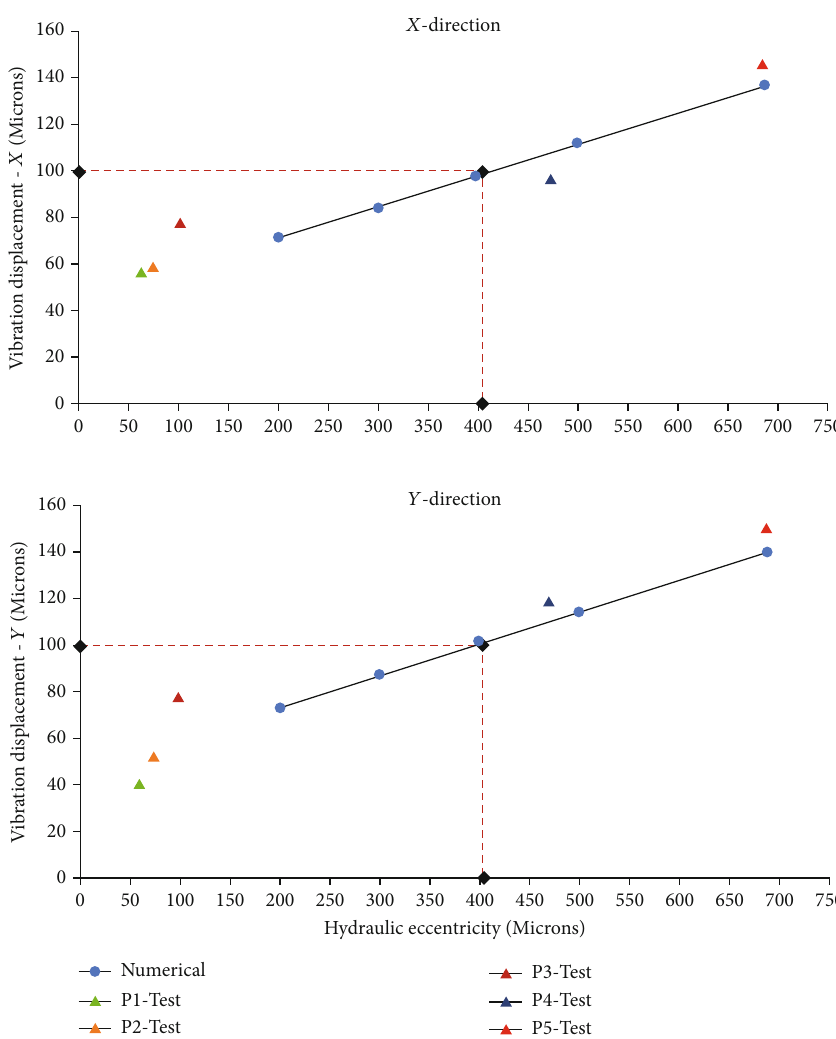
Figure 8: Vibration displacement variation at motor end with hydraulic eccentricity in X and Y